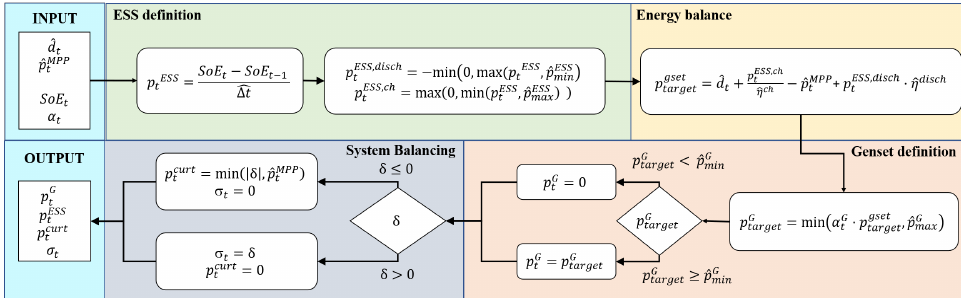
Figure 3. Decodification process of the EA formulation for the scheduling optimization